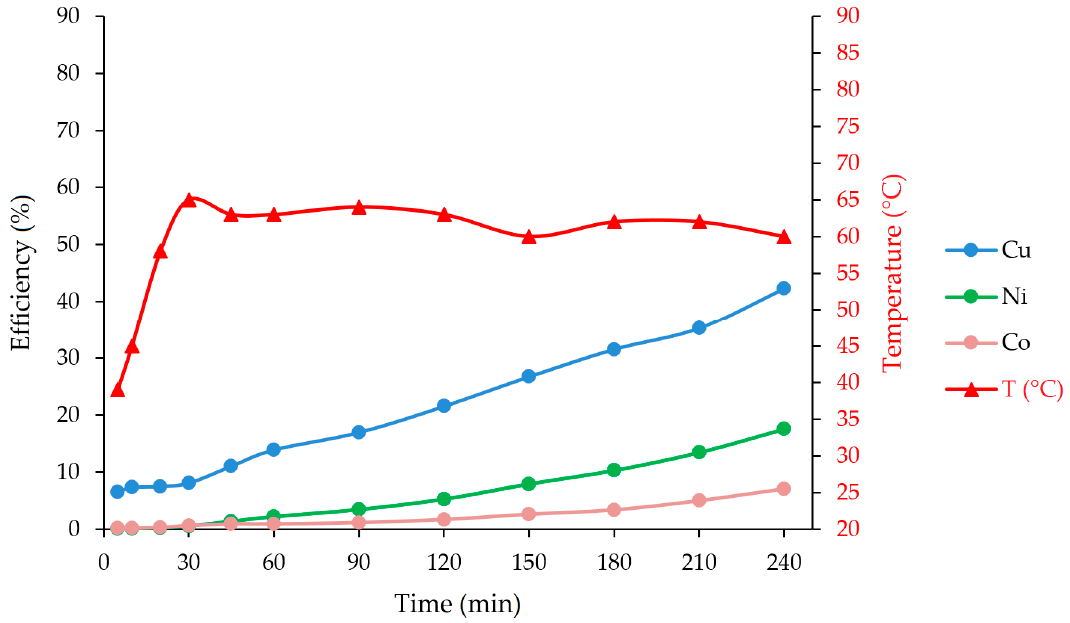
Figure 7. Kinetics of metals extraction during ammoniacal leaching with microwave (30 W).